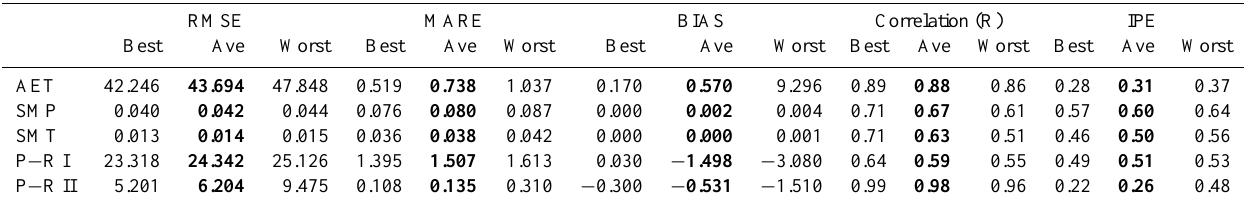
Table 19. Accuracy results of ensemble prediction based on average output values of six techniques. RMSE MARE BIAS Correlation (R) IPE Best Ave Worst Best Ave Worst Best Ave Worst Best Ave Worst